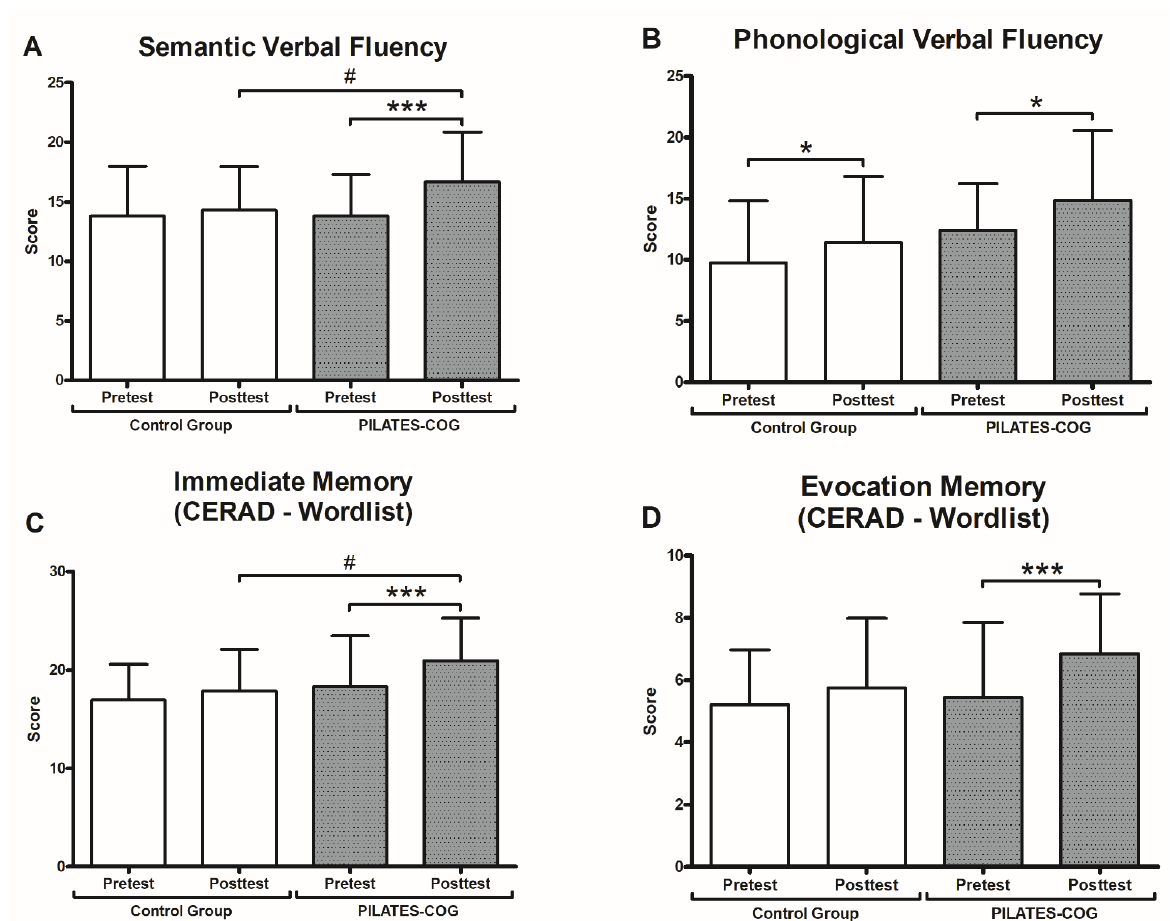
Figure 2. Cognitive Performance. Values presented as mean ± SD. * = p < 0.05; *** = p < 0.001 (Pre x Post Test). # = p < 0.05 (Post × Post Test). CERAD = Consortium to Establish a Registry for Alz- heimer ’ s Disease. ( A , B ) Verbal Fluency. ( C ) Immediate Memory. ( D ) Evocation